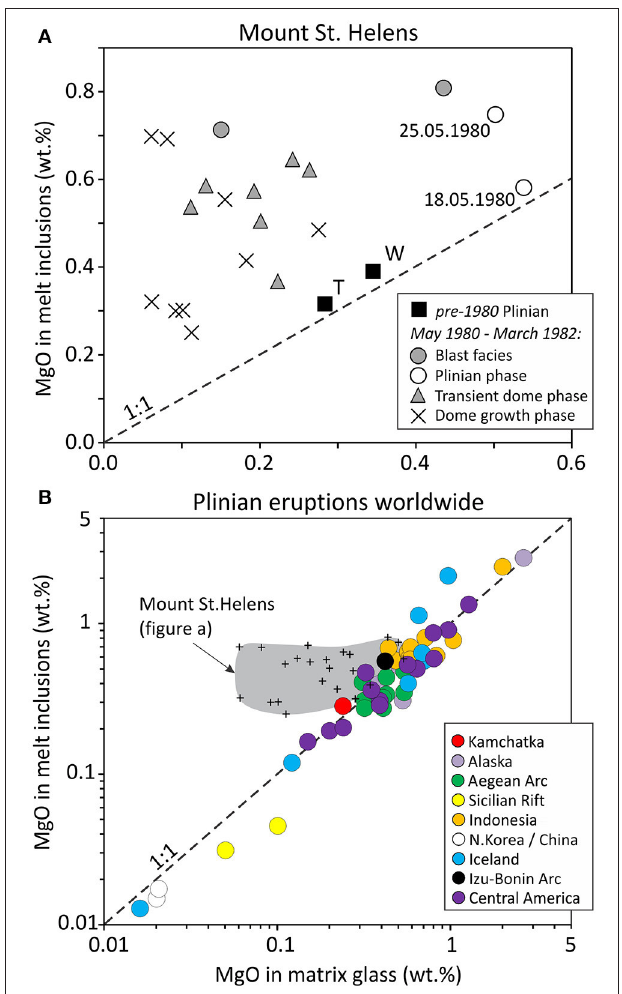
FIGURE 3 | Comparison of MgO content in matrix glasses and melt inclusions in minerals. (A) Data for different phases of Mount St. Helens 1980-1982 and pre-1980 eruptions ( Melson, 1983); (B) Average MgO in matrix glasses and melt inclusions for 28 plinian eruptions woldwide. We show 55 matrix glass-melt inclusions pairs representing different eruptions, samples and different host minerals (plagioclase, alkali feldspar, olivine, amphibole, magnetite, quartz, clino- and orthopyroxene). Data are from Cadoux et al. (2014), Gioncada and Landi (2010), Horn and Schmincke (2000), Kutterolf et al. (2008a,b), Larsen (2006), Mandeville et al. (1996), Naumov et al. (2008), Plechov et al. (2010), Portnyagin et al. (2012), Schattel et al. (2014), Straub and Layne